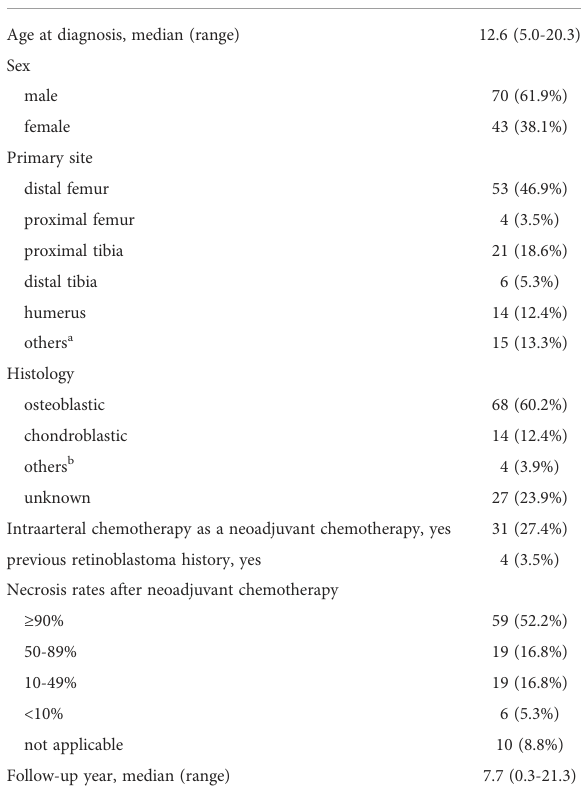
TABLE 1 Patient